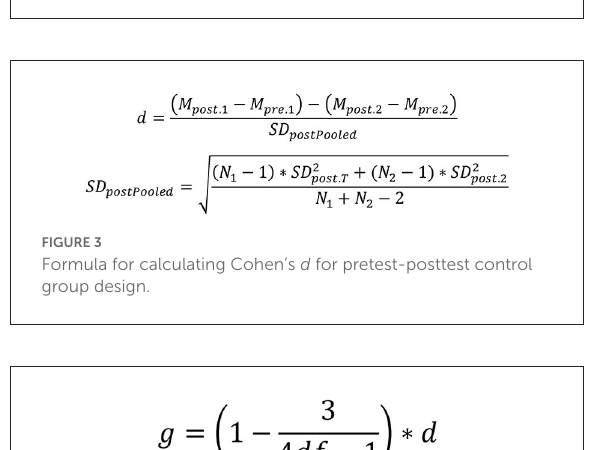
FIGURE2 Formula for calculating Cohen’s d for posttest-only control group design.